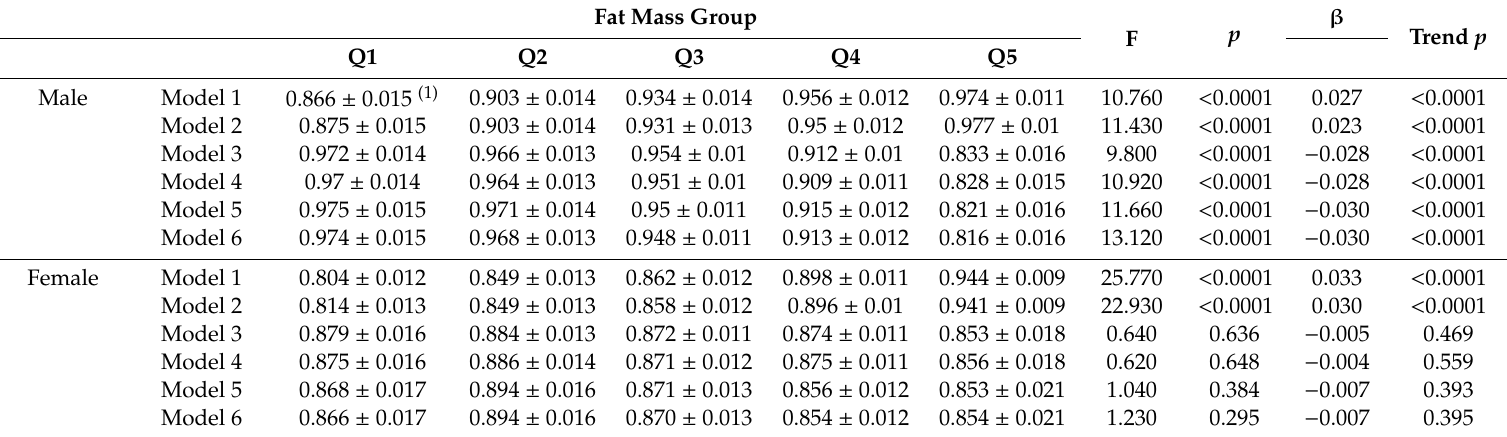
Table 2. Analysis of the bone density (total femur) di ff erences of fat mass